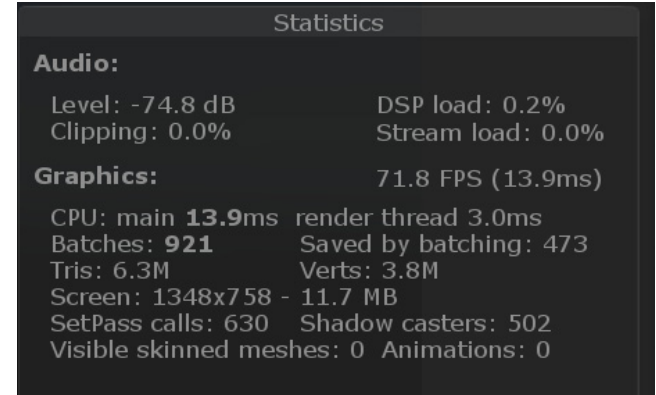
Figure 15. Unity3d scene information.